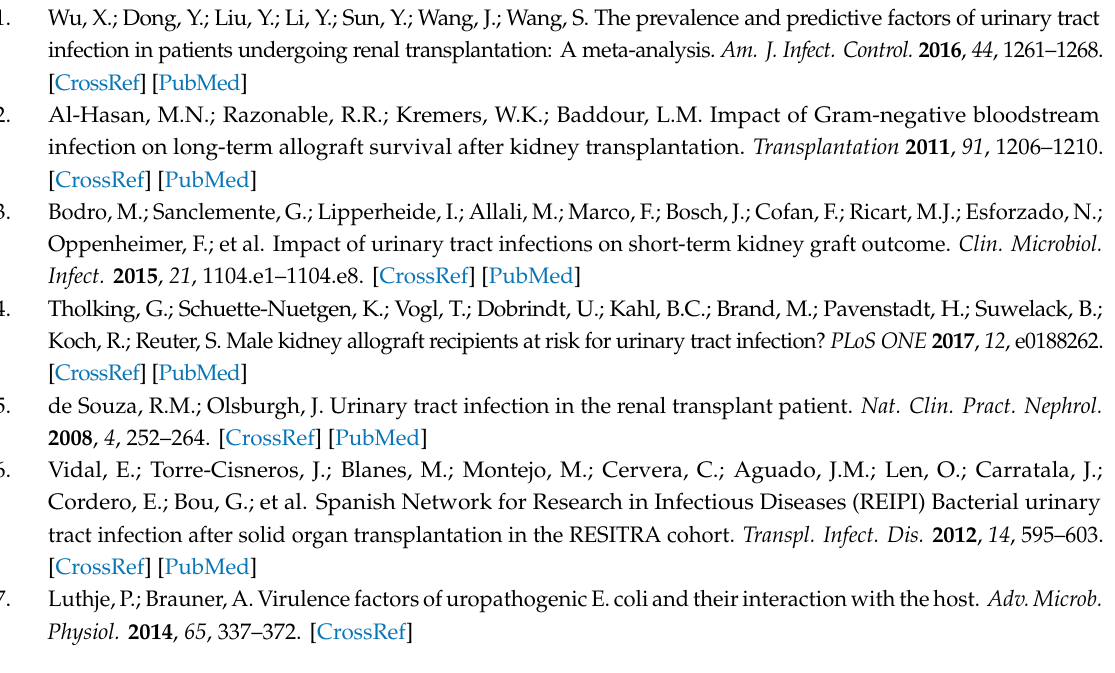
Figure S1: Representative biofilm morphotypes expressed by UPEC isolates on Congo Red agar plates, Figure S2: Manhattan Plot of Fisher’s exact test p -values for the prevalence of individual virulence factors (VF) in an isolate group (KTx or control). The red line separates VFs with p -values < 0.05 from VFs without significant association with an isolate group. The green line separates VFs with significant association ( p < 0.05) after the Bonferroni correction, Figure S3: Principal Coordinates Analysis (PCoA) to examine the grouping of UPEC isolates according to the presence / absence of virulence-associated genes, their phylogenetic group and their isolate group (KTx vs. control group). The axes are scaled with eigenvalue scaling using the square root of the eigenvalue and indicate the percentage of variation explained in the PCoA. KTx strains are marked with ( + ) and control strains are marked with ( • ). The phylogroup of each strain is color coded (phylogroup A = blue, phylogroup B1 = light green, phylogroup B2 = dark green, phylogroup C = brown, phylogroup D = pink, phylogroup E = red, phylogroup F = orange, clade V = black), Table S1: Additional KTx recipient and donor data, Table S2: Distribution of sequence types (STs) in relation to KTx and control UPEC isolates, Table S3: List of VFs significantly associated (Fisher’s exact test) with either KTx or control UPEC isolates, Table S4: Resistance genes (RGs) with the largest di ff erences between KTx and control isolates, Table S1: Distribution of the rdar / ras, saw and mucoid morphotypes expressed by KTx and control UPEC isolates, Table S6: Calcofluor binding KTx and control UPEC